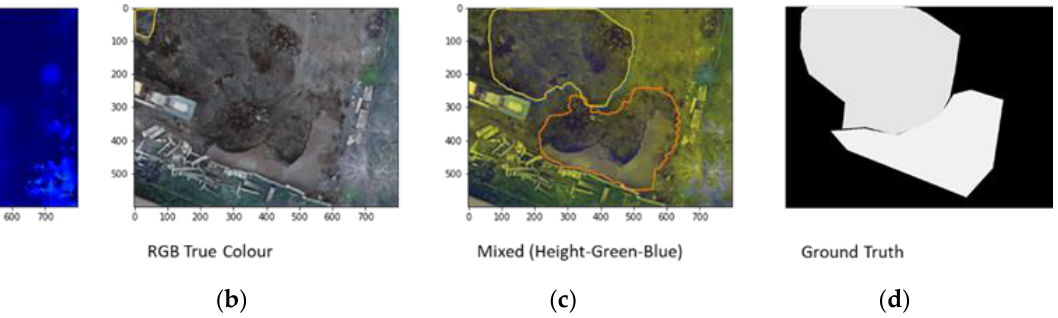
Figure 25. Results from different models using different feature combinations shown for the same area of test site B. ( a ) One out of two heaps detected by a model using only relative height represented as RGB heat map as features. ( b ) None of the two heaps were detected by a model using the RGB true color of the orthomosaic as features. ( c ) Both heaps accurately detected by a model that uses relative height together with the green and the blue channel as features. ( d ) The respective ground-truth masks.